Question: Condense the content of this figure into a single sentence.
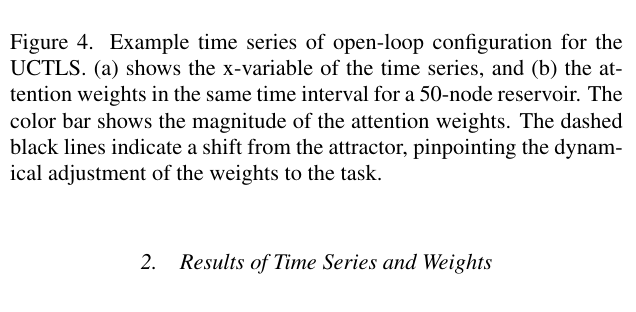
Answer: (a) illustrates an open-loop time series. The upper graph displays the time series of the x1-variable from the ex- posed Lorenz attractor of the true system (in blue) alongside the predicted time series (black line), plotted against the time in Lyapunov times with λLorenz ≈0.91. The similarity be- tween the prediction and the actual system’s behavior is accu- rate. A more interesting insight comes from Fig. 4(b), which shows the computed absolute value of the attention weights watt for each node within the reservoir across the same pe- riod. Nodes with higher weight magnitudes are assumed to be more important for predictions at specific time points. Ver- tical dashed lines indicate a pattern change corresponding to moments where the system’s trajectory shifts from one side of the attractor to the other. A corresponding shift in the at- tention weights’ structure implies that the attention-enhanced reservoir can adapt dynamically to the time-dependent char- acteristics of the task